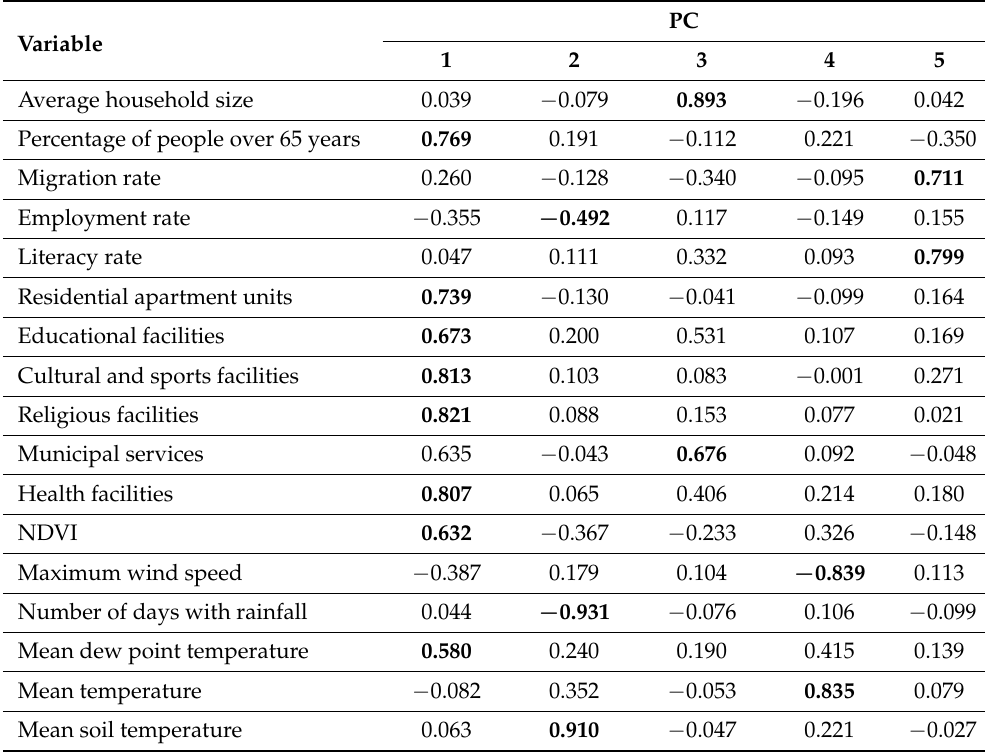
Table 5. The loading of each variable on each PC using the rotated component matrix (rotation converged in 10 iterations). The bold values are associated with the candidate variables for the related PCs.